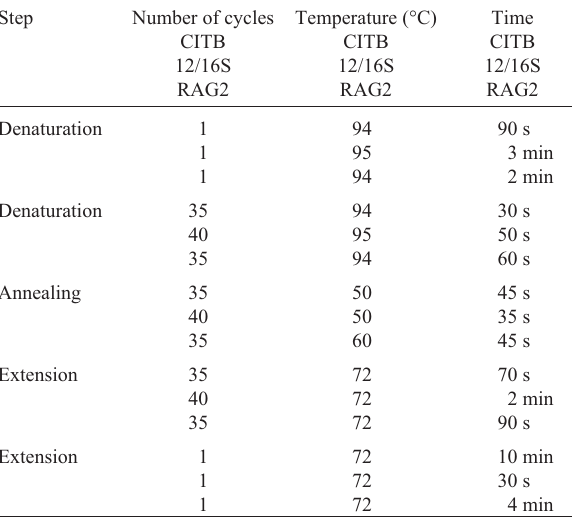
Table 2 - Reaction parameters for the five primer